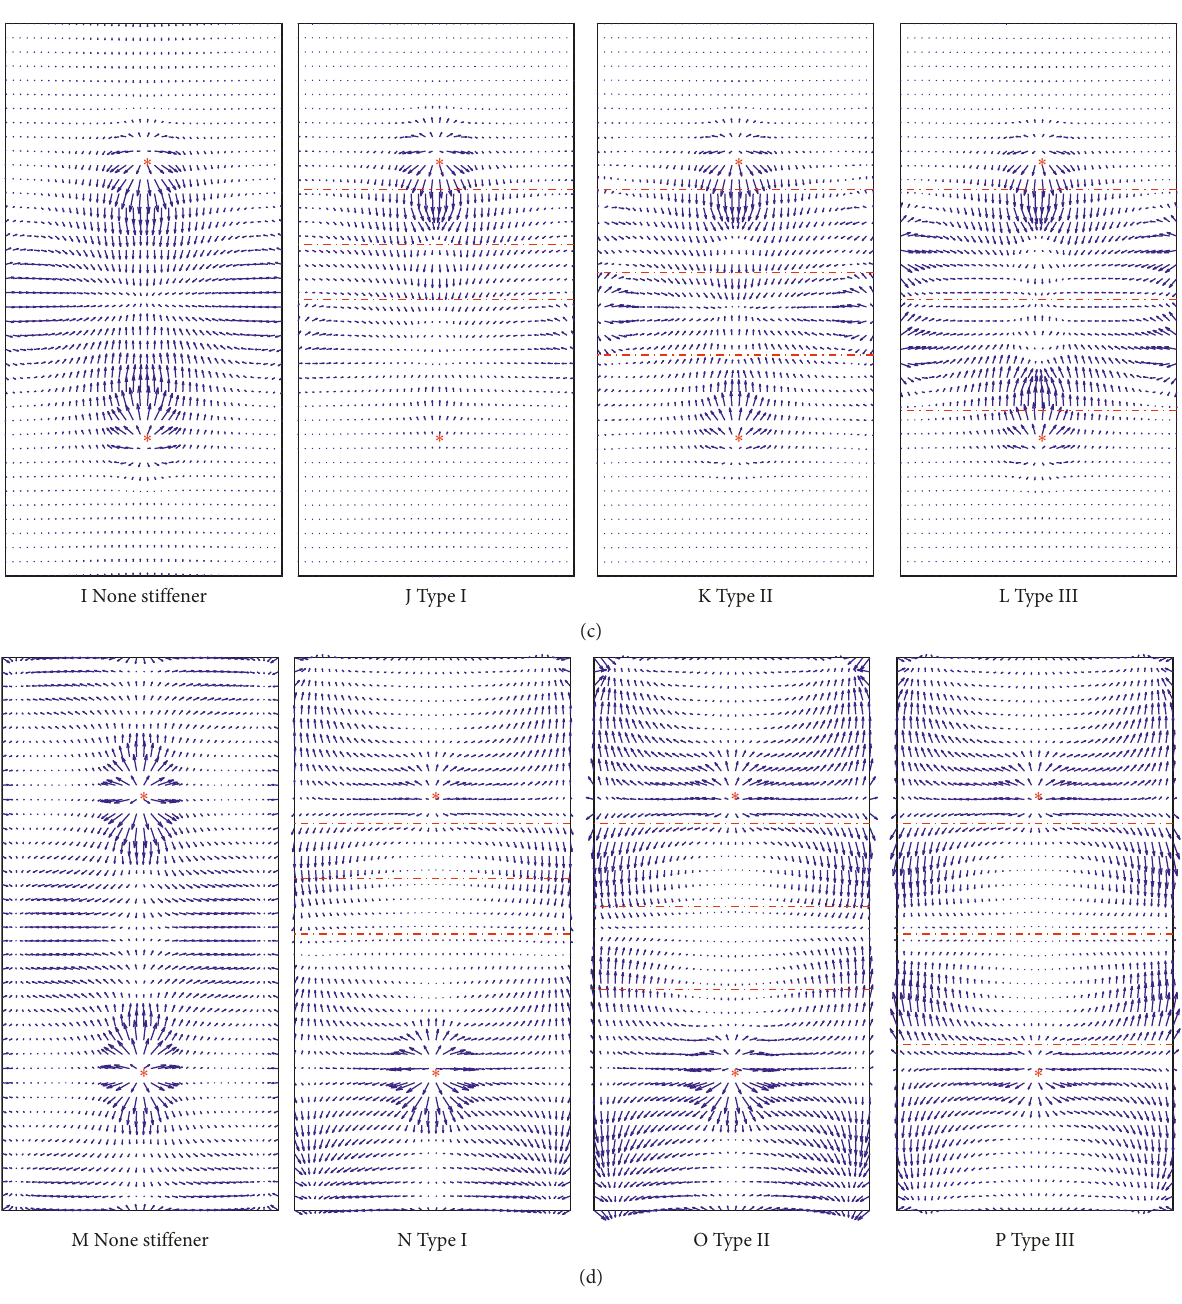
Figure 11: Structural intensity of a rectangular plate attached by beams with different configurations under two-point excitation: (a) CSCS; (b) SFSF; (c) E 77 E 77 E 77 E 77 ; (d) E 55 E 55 E 55 E 55